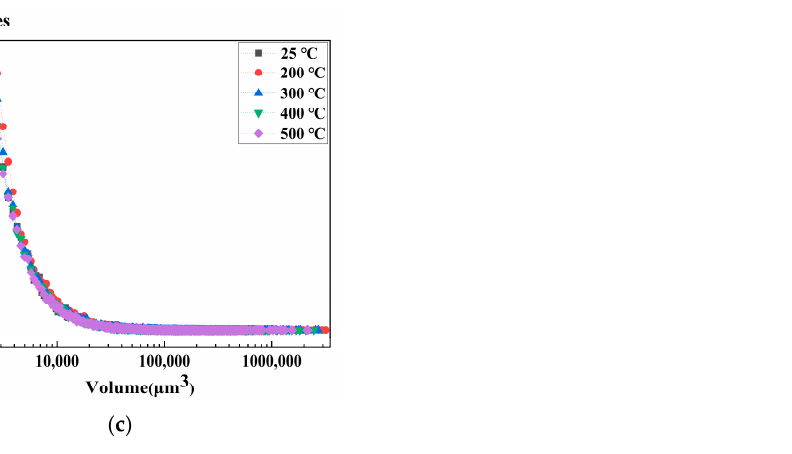
Figure 3. The amount of statistical distribution of three kinds of pores at different temperatures. ( a ) Type Ⅰ pores. ( b ) Type Ⅱ pores. ( c ) Type Ⅲ pores.